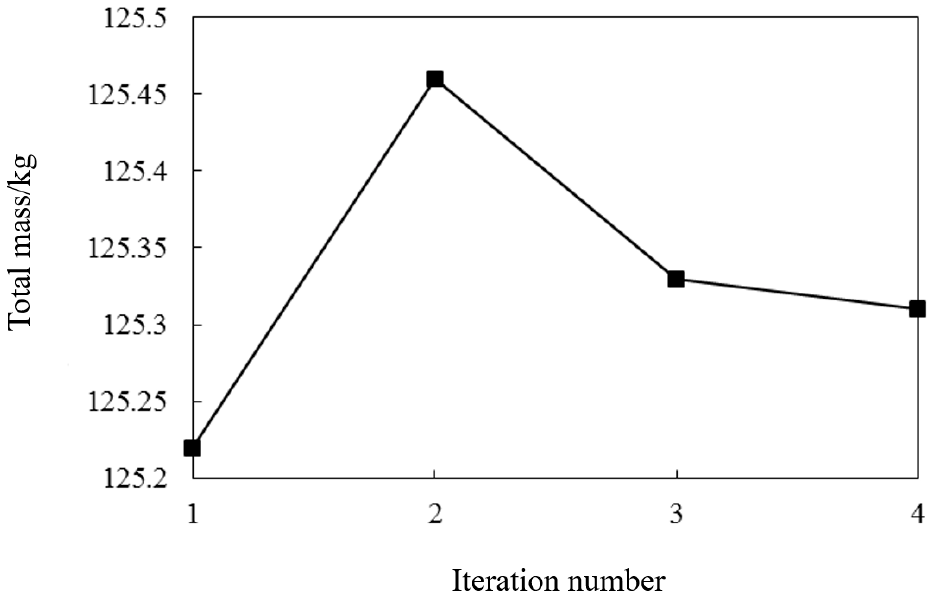
Figure 7. Objective iteration curve.